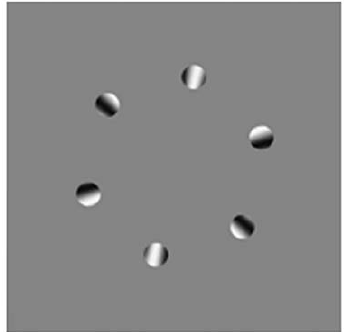
Figure 5. The rotational reveals illusion (see Movie S4). A ring of ovals moves counter-clockwise. Within each oval is an internal gradient that moves clockwise. When viewed foveally, the ring appears to rotate counter-clockwise, but when viewed peripherally, the ring appears to rotate clockwise. When the background is near the same luminance as the white or black of the internal gradient, the ring appears jumbled when viewed peripherally.